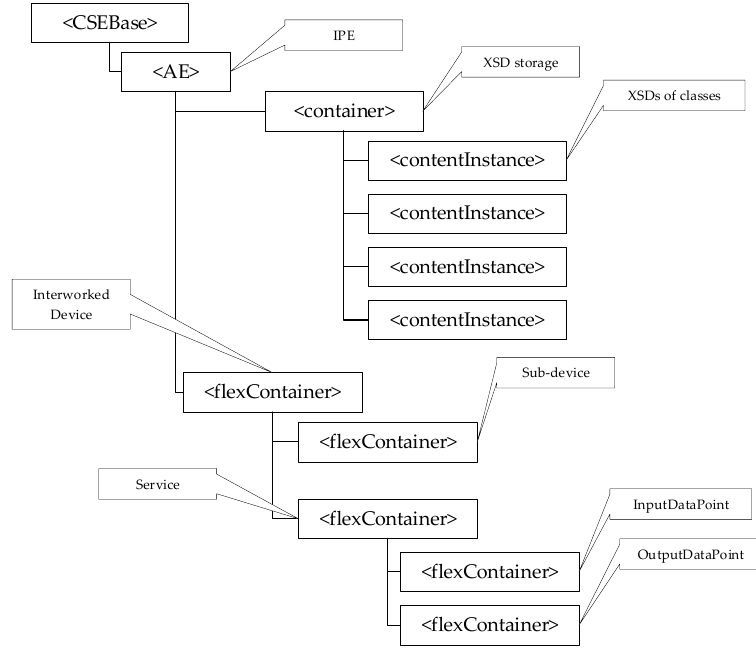
Figure 8. CSE structure in oneM2M ‐ based Interworking.